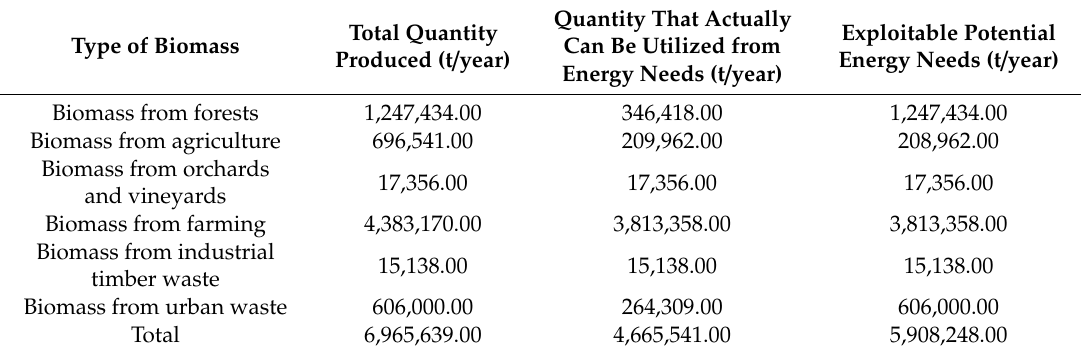
Table 7. Total production potential of biomass in Kosovo [23].